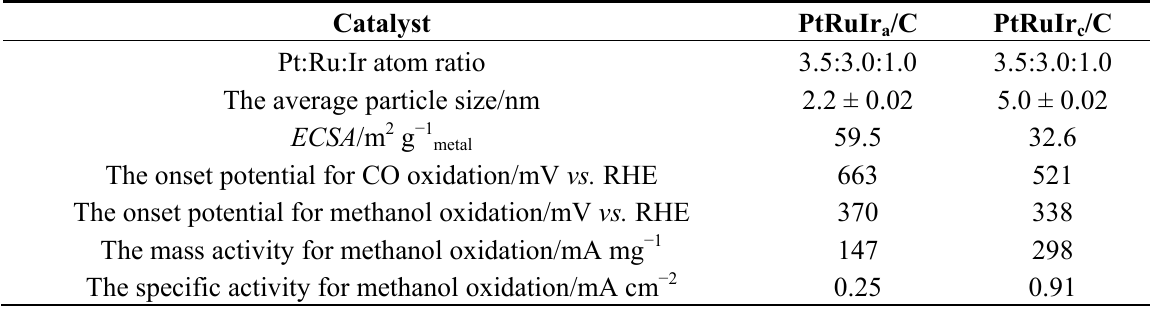
Table 1. Composition the average particle size, and the electrochemical performance of the PtRuIr /C and PtRuIr /C catalysts. a c